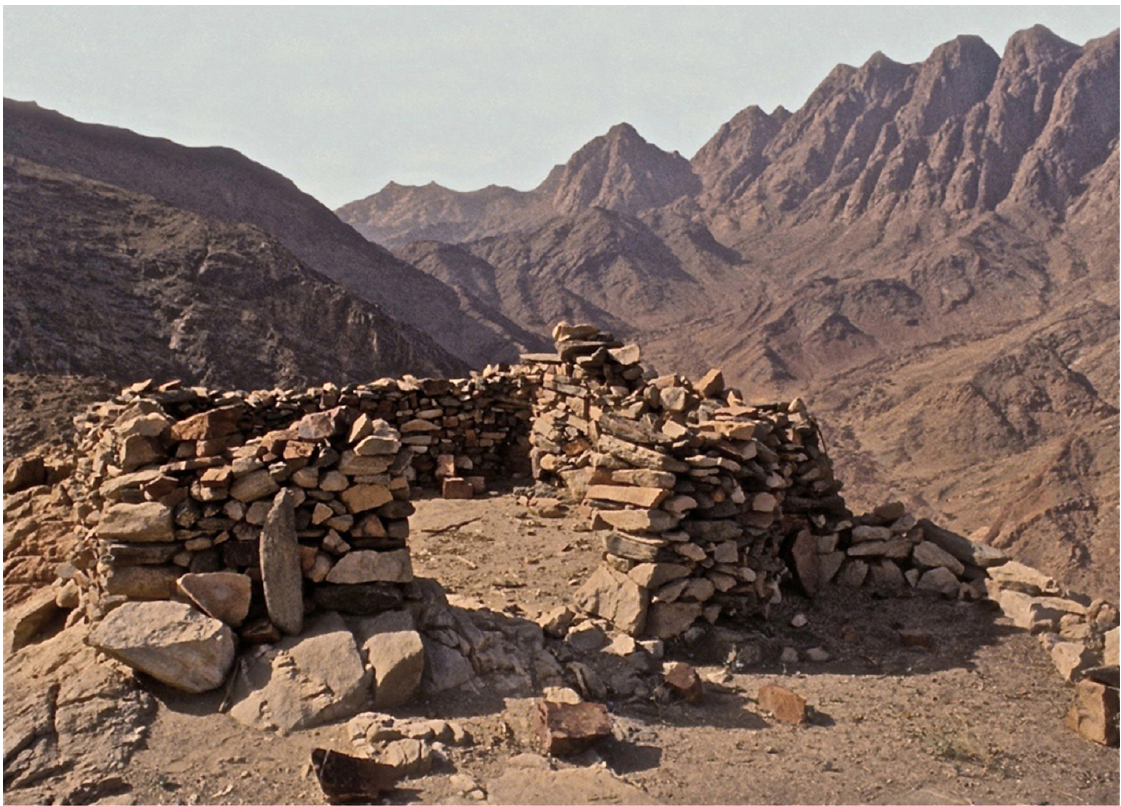
Figure 19 The Bedouin cult enclosure at the Summit of Jebel Moneijah, view from the